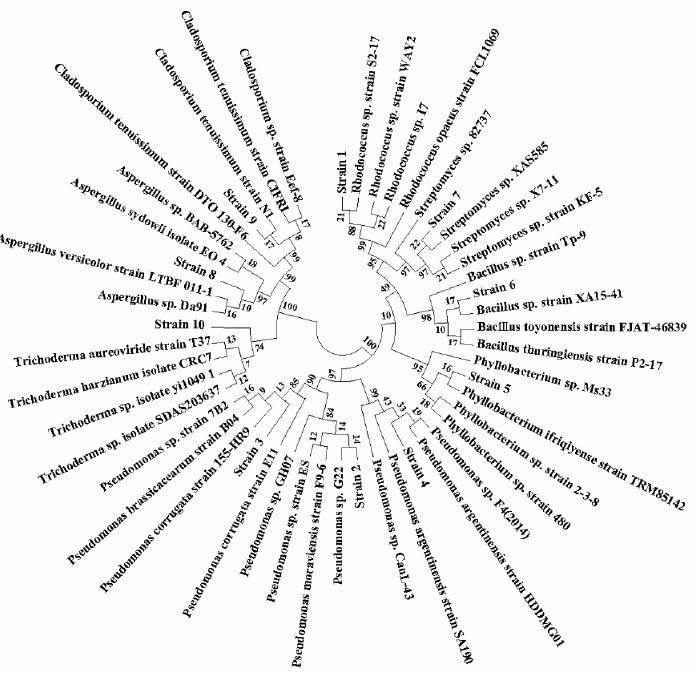
Figure 2. Phylogenetic diagram of the isolated strains.